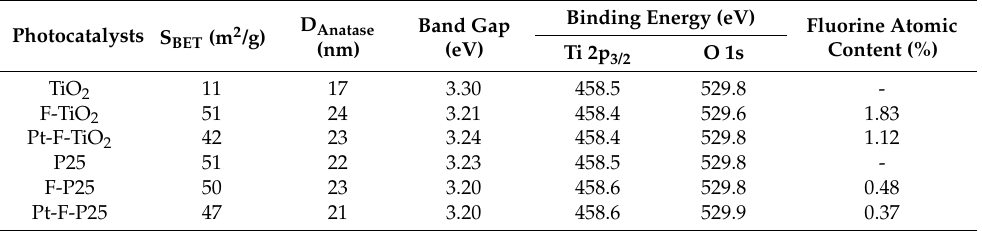
Table 1. Summary of the characterization